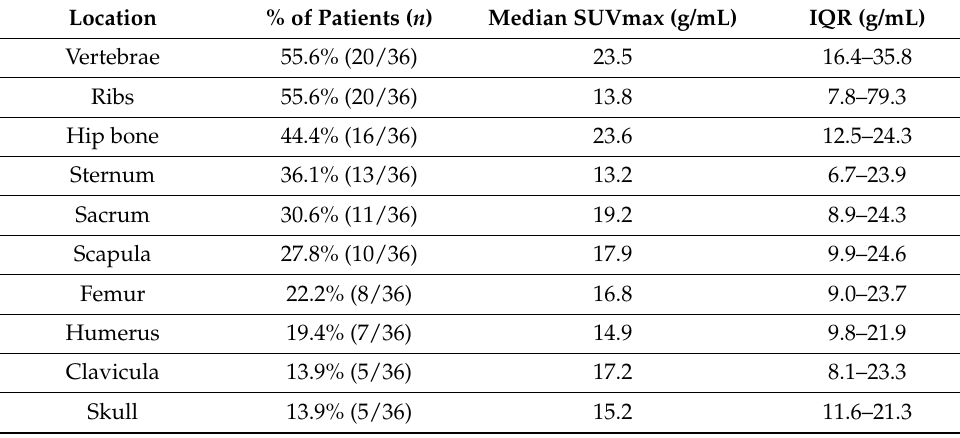
Table 3. Summary of per-patient localization and SUVmax.